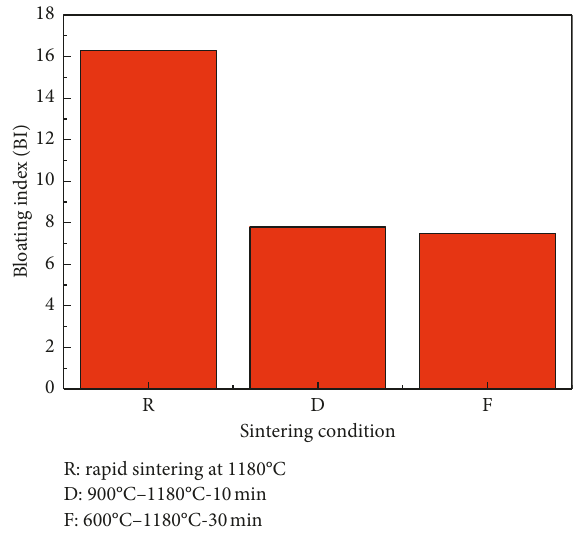
Figure 11: Bloating index (BI) of the sintering aggregate.